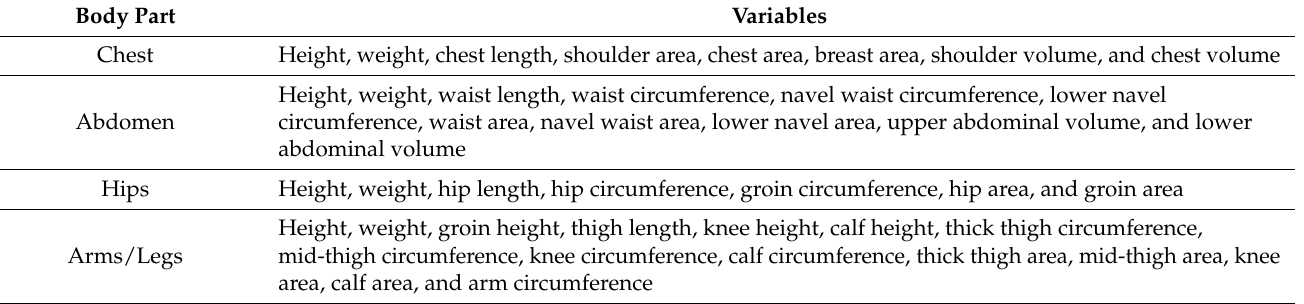
Table 3. Three-dimensional scanner body values according to the fat percentage for each body part.